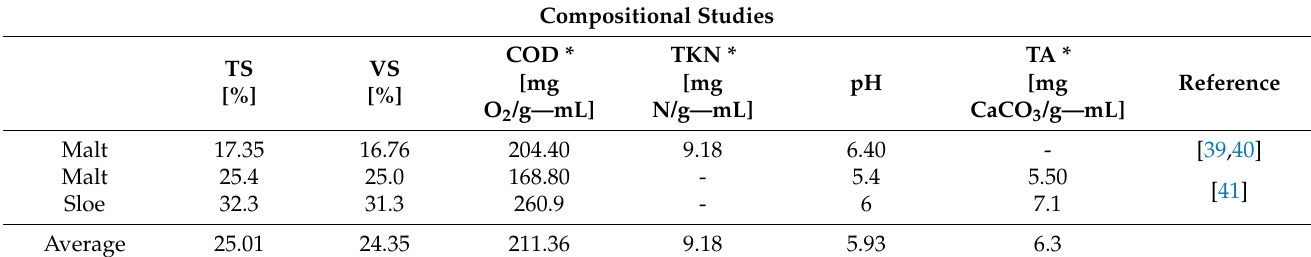
Table 5. Results obtained from bibliographic analysis, to be compared to the results of this research. Compositional